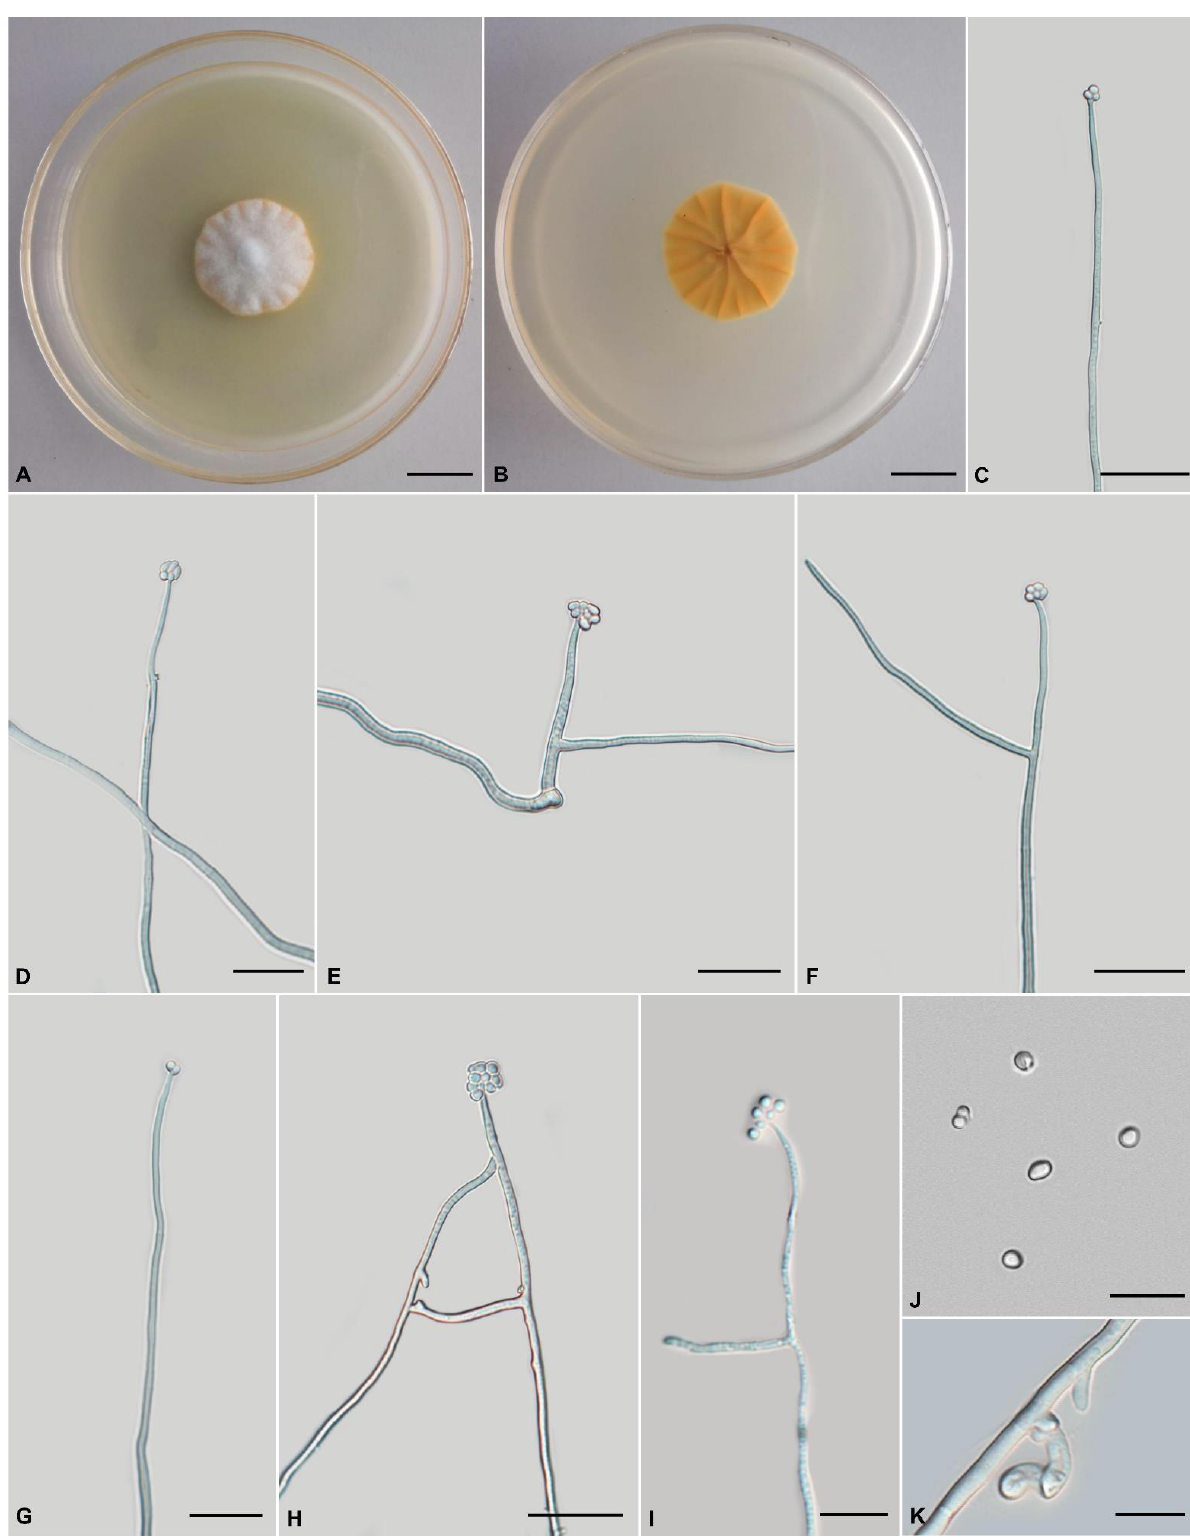
Figure 3. Morphology of Tolypocladium pseudoalbum (YFCC 875, ex-type living culture). ( A , B ) Cul- ture characteristics on PDA medium incubated at 22 °C for 14 days; ( C – I ) phialides; ( J ) conidia; ( K ) chlamydospore. Scale bars: A – B = 10 mm; C – H = 20 μm; I– K = 10 μm.